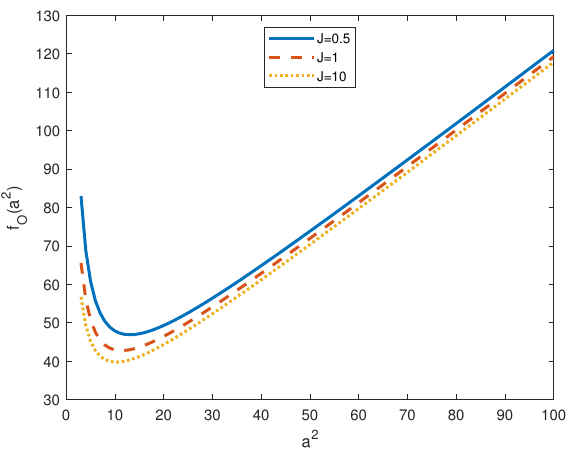
Figure 8. Plot of f o ( a 2 ) for γ = 0.8, k r = 1.5, η = 0.2, T 2 = 10.